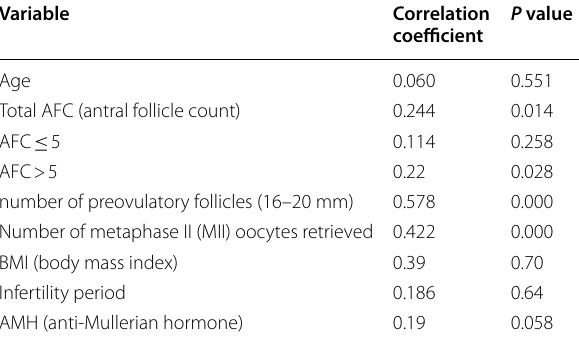
Table 2 Correlation among FORT (Follicular Output Rate) and